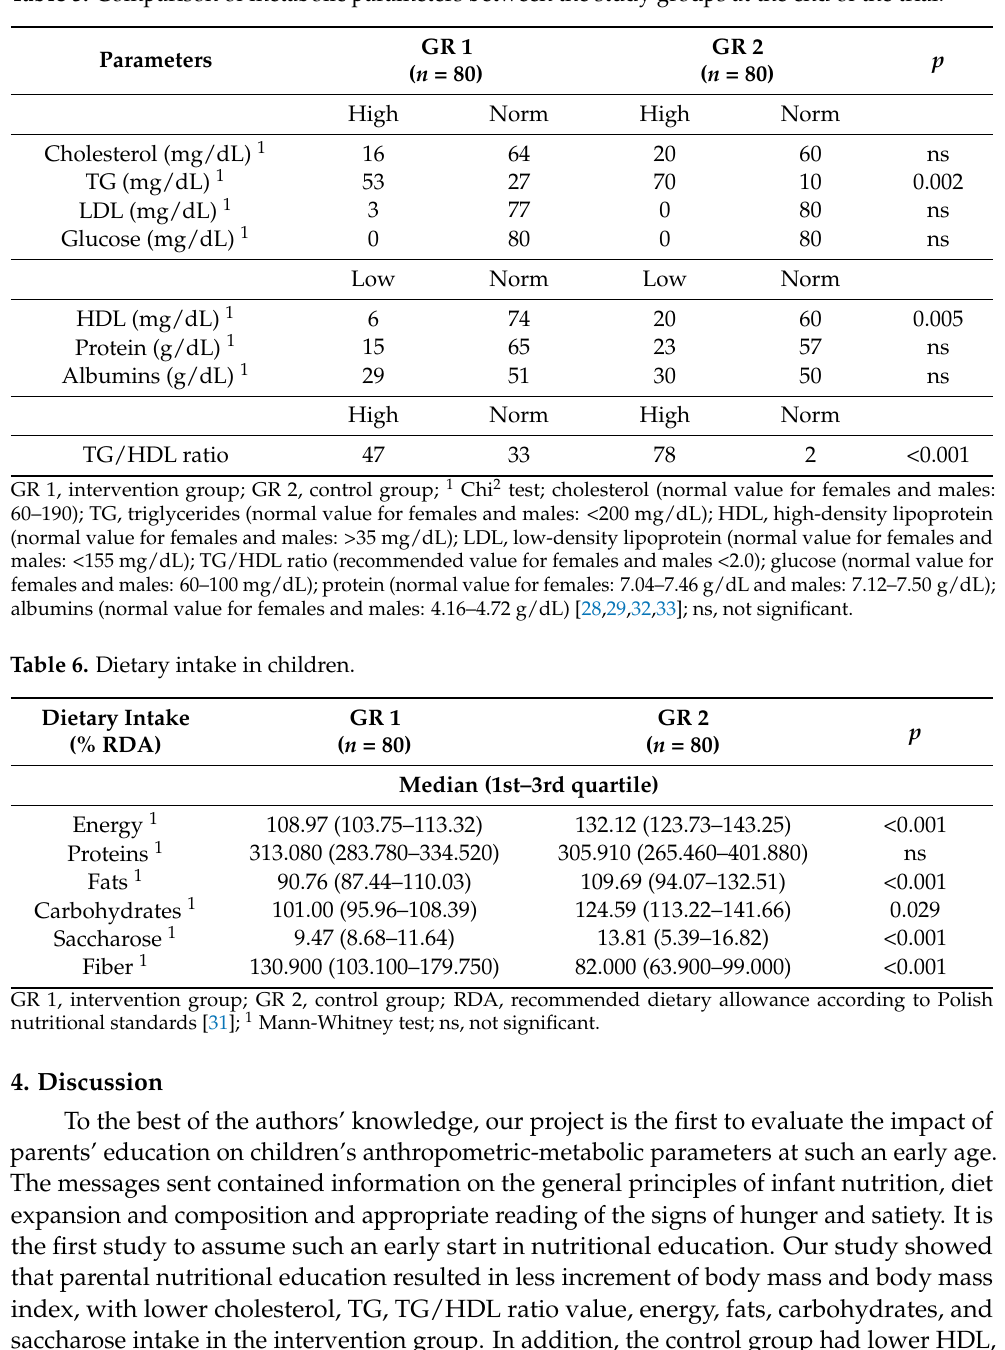
Table 5. Comparison of metabolic parameters between the study groups at the end of the trial.